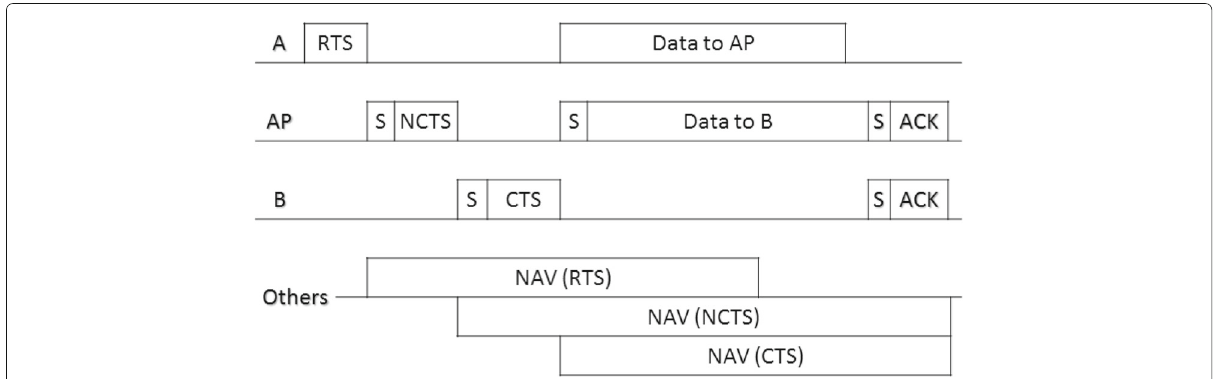
Fig. 7 A HDN initiates the transmission